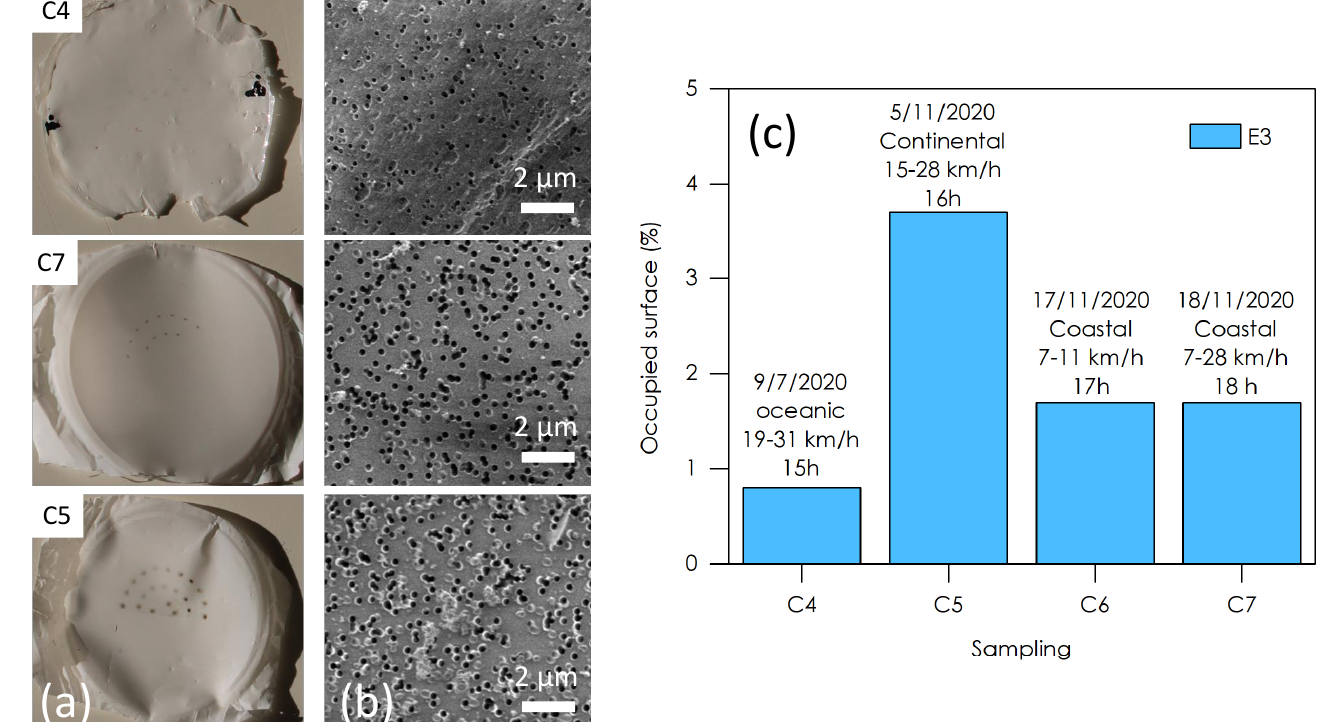
Figure 8. ( a ) Photograph of the polycarbonate filters of the E3 stages of three samples taken at Le Croisic under different air mass conditions: oceanic (C4), continental (C5), and costal (C7). ( b ) Typical SEM images used for particle density measurements. ( c ) Particle density per unit area for 4 samples from Le Croisic (C4, C5, C6, and C7).